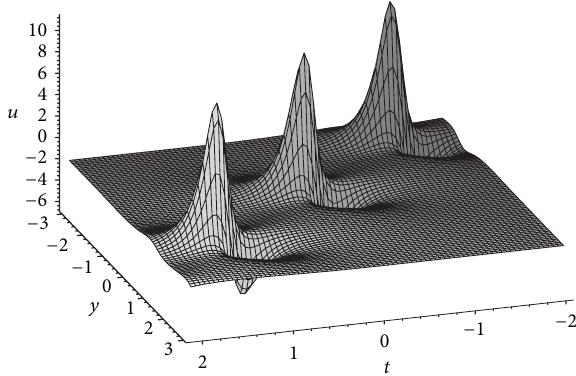
Figure 1: The figure of 𝑢 1 (𝑡,𝑥,𝑦, 𝑧) as 𝑢 0 = −2 and 𝑏 = 3 .